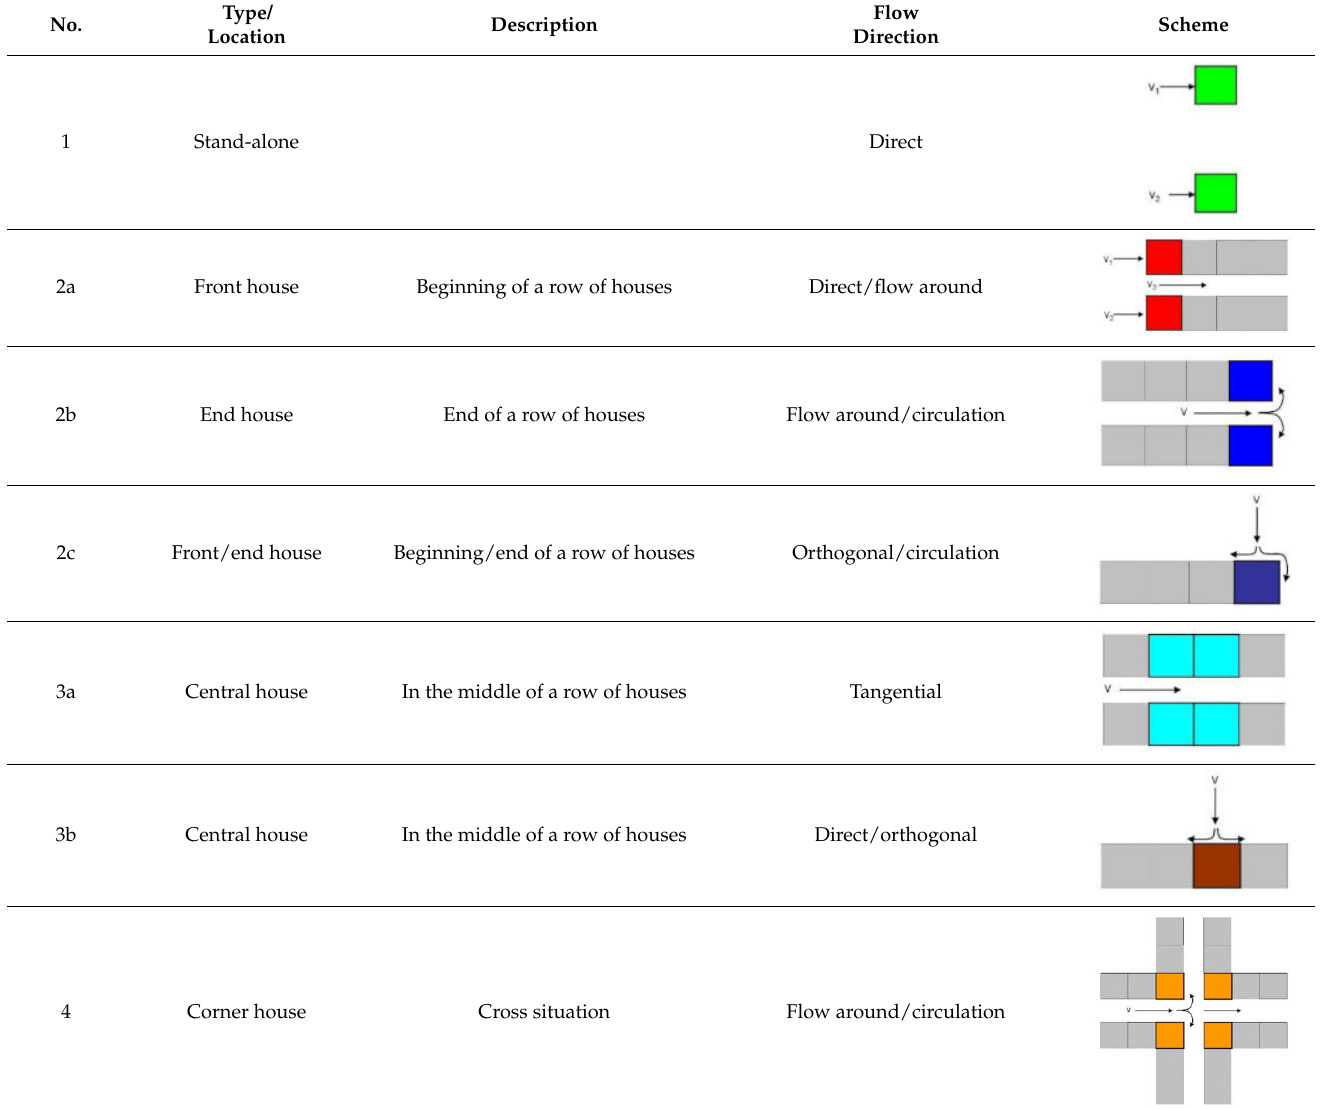
Table 9. Classification scheme with respect to the location of buildings and direction of inflow